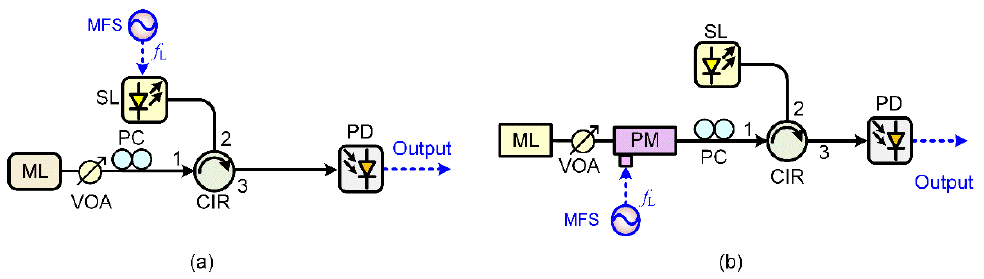
Figure 5. Photonic microwave stabilization for P1 dynamics using microwave modulation. ( a ) Direct microwave modulation; ( b ) optical modulation sideband injection locking. MS: microwave frequency synthesizer; PM: phase modulator.